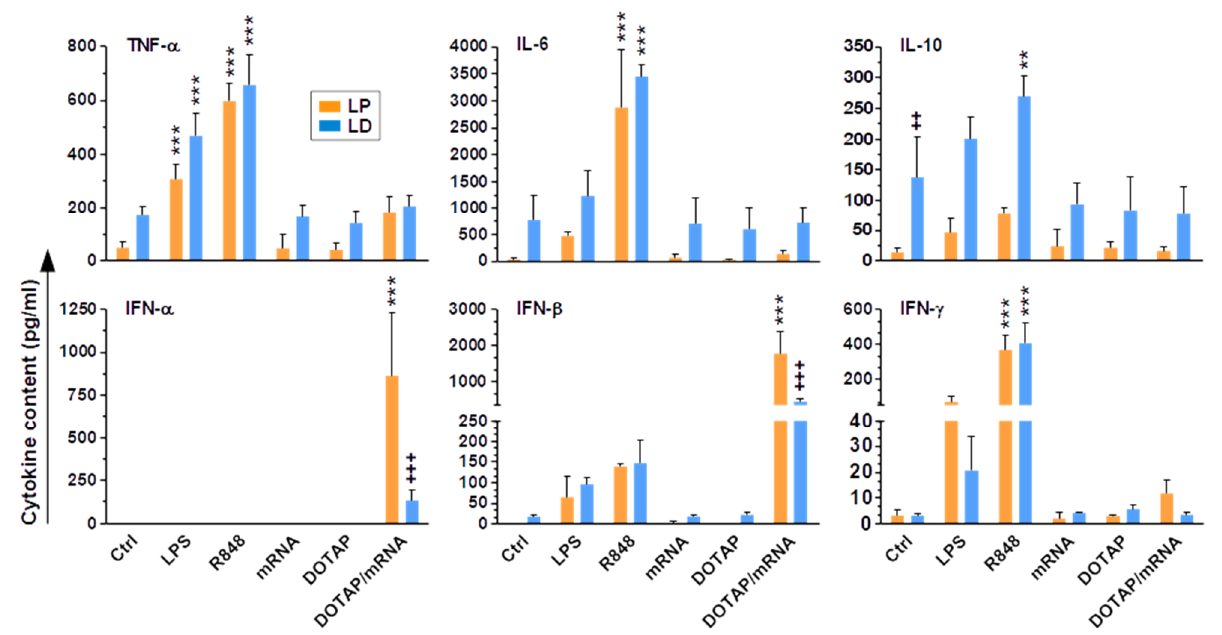
Figure 4. Liver NPCs generate cytokines in an adjuvant-specific manner and depending on the enrichment method used. Supernatants of differentially stimulated liver NPCs (see Figure 3) were assayed for cytokine contents in culture supernatants (mean ± SEM, n = 3). Statistically significant differences versus * according Ctrl and versus + LP are indicated (one way ANOVA, Tukey test). ** , ++ p < 0.01, *** , +++ p < 0.001.